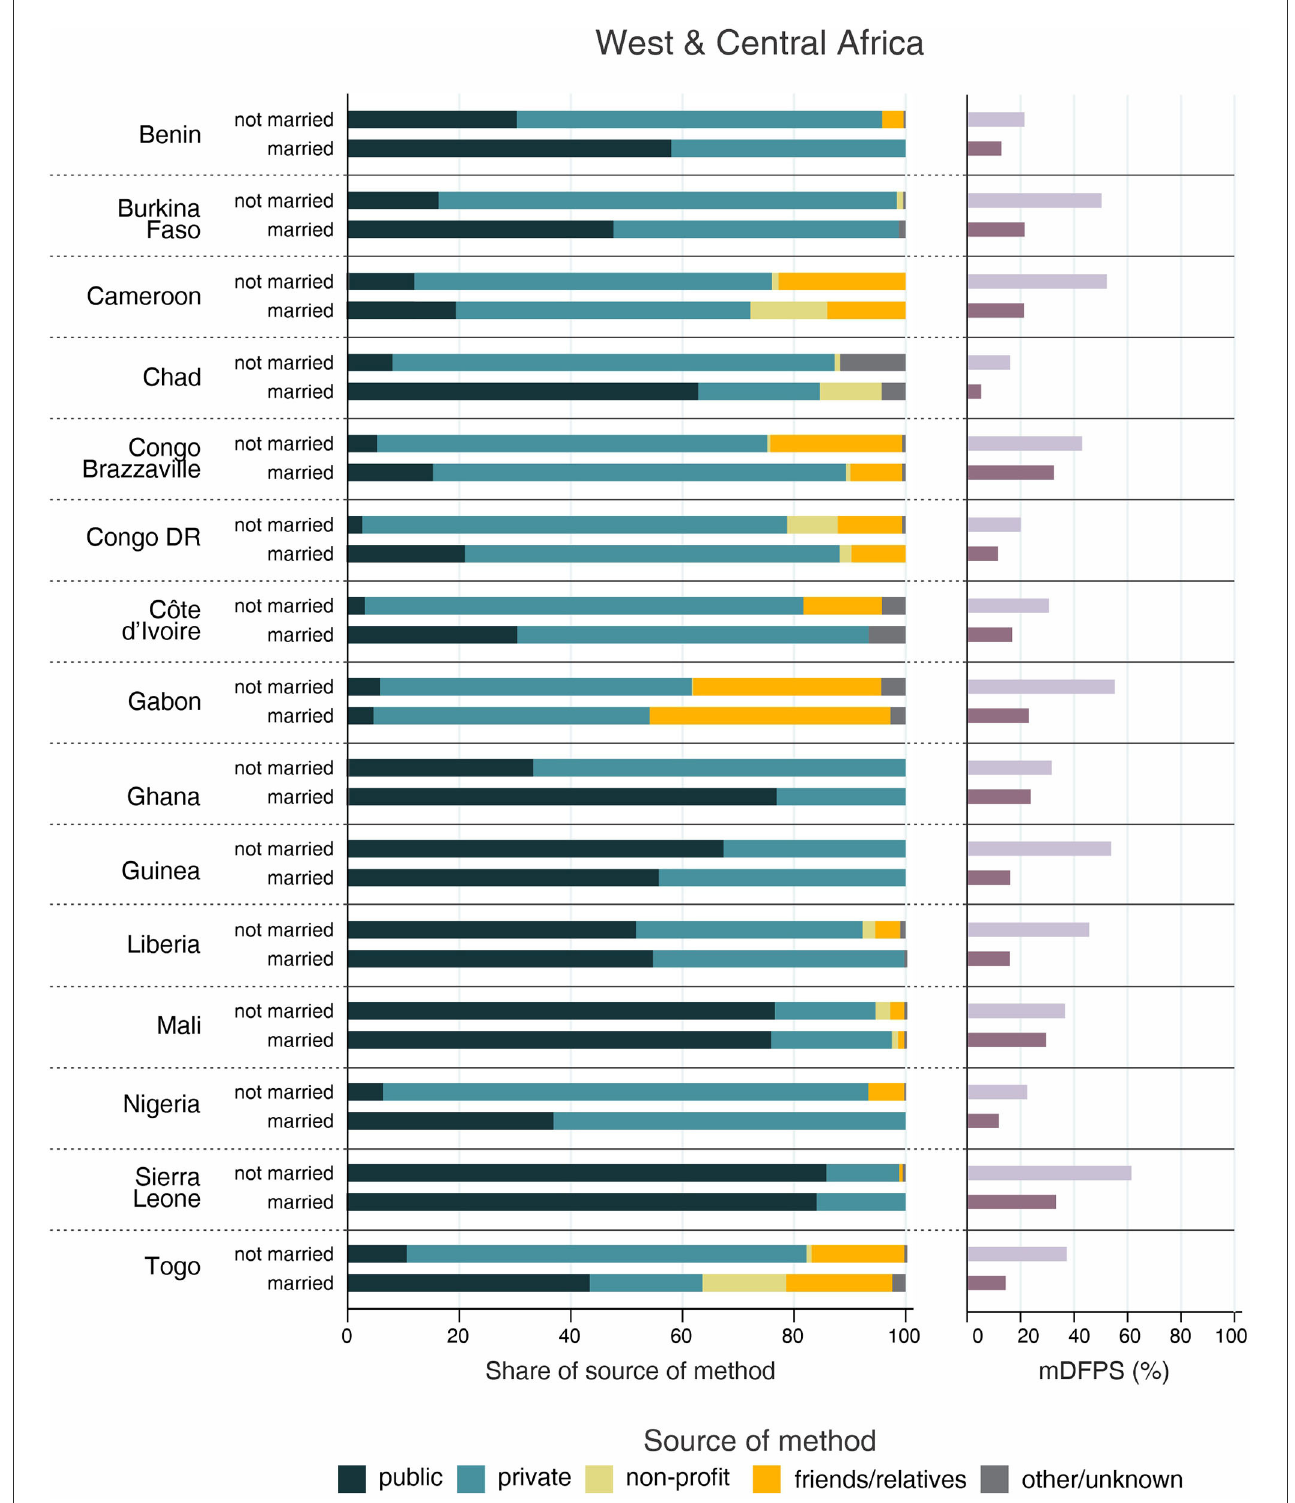
FIGURE5 Demand for family planning satisfied by modern methods (mDFPS) and share of source of method by adolescents’ marital status in West and Central Africa. Source: DHS, 2010-2021. Countries missing information on never married women or with fewer than 25 cases have been suppressed.